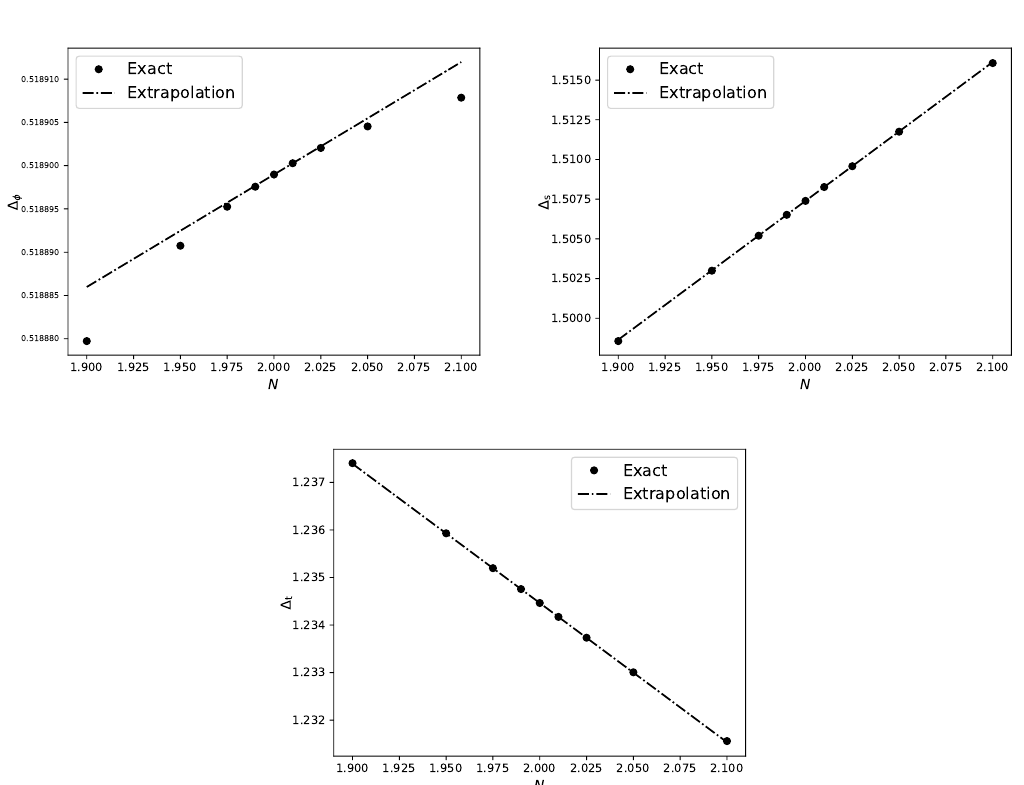
Figure 2: Comparison of the first-order prediction (7) for the location of the minima nearby the ( d = 3, N = 2 ) minimum to their actual value. Upper left: Comparison for ∆ φ . Upper right: Comparison for ∆